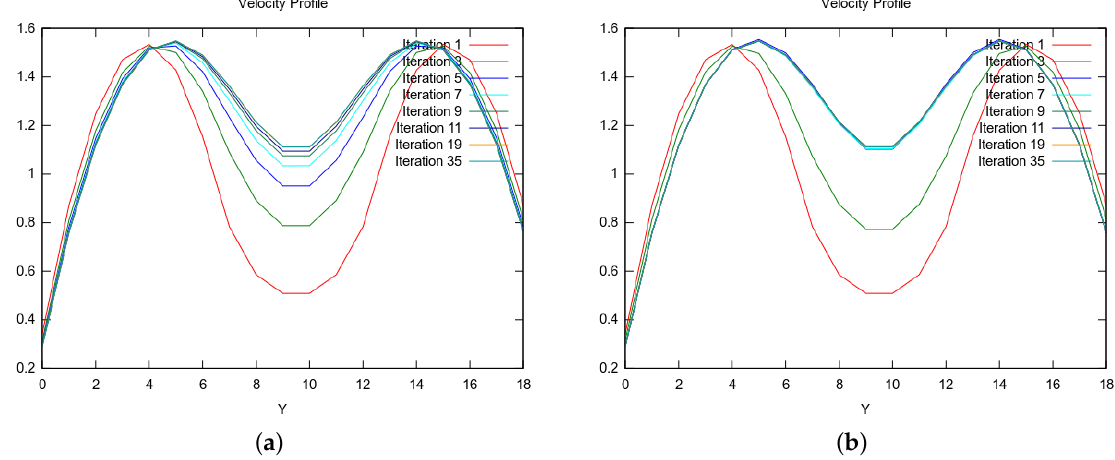
Figure 8. Convergence of the velocity profile for channel flow past a spherical obstacle at cross-section at x = 2.0, y ∈ [ 0.0,2.0 ] towards steady state. ( a ) Simple parallel coupling; ( b ) Anderson accelerated coupling.